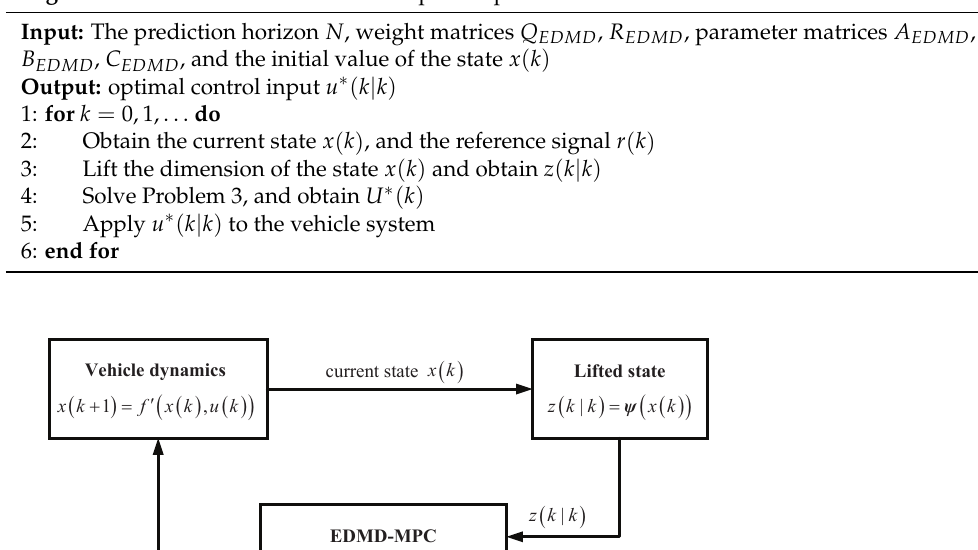
Algorithm 5 EDMD-MPC based on Koopman operator